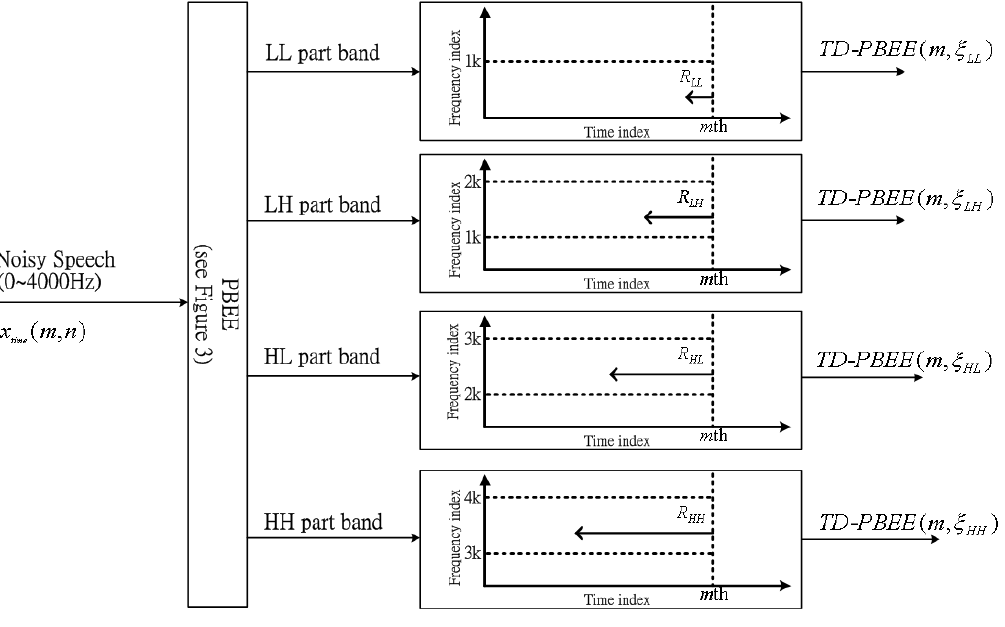
Figure 4. The block diagram of four TD-PBEE values determined from four PBEEs over